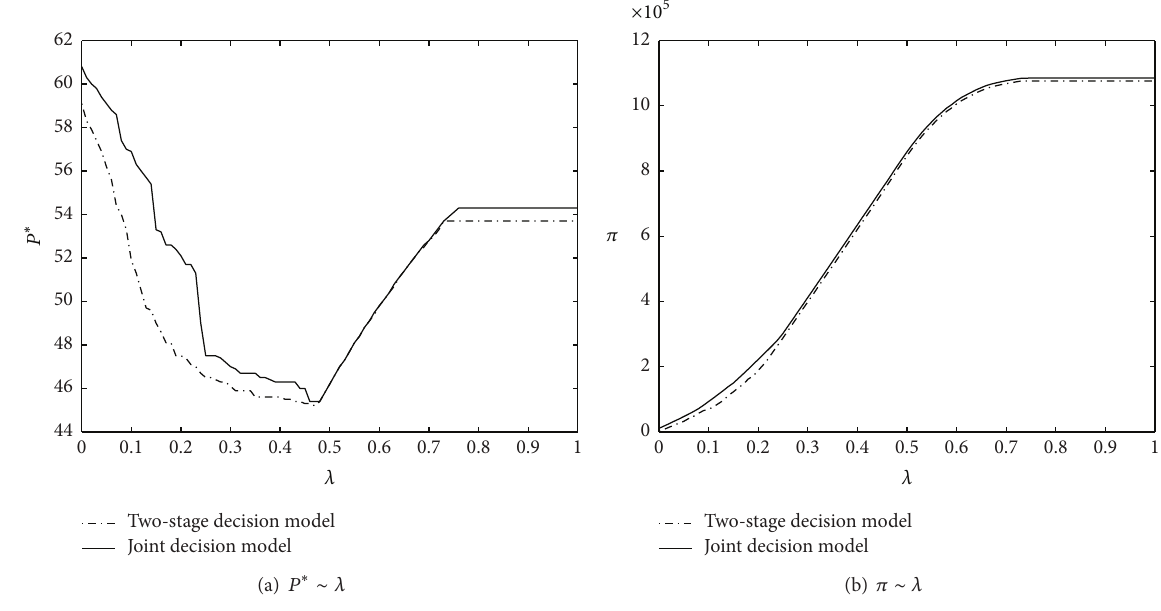
Figure 2: The influences of repeat-purchase rate 𝜆